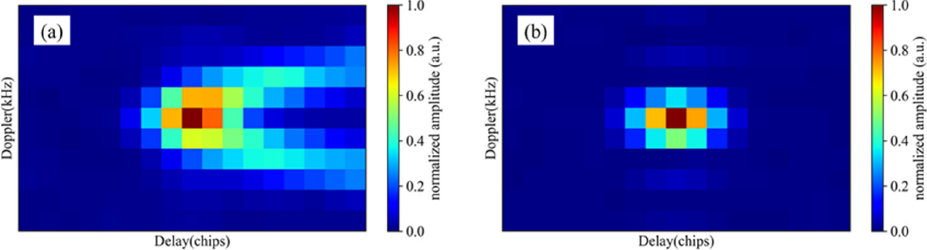
Figure 2. Illustration of the DDM and corresponding surface reflections.